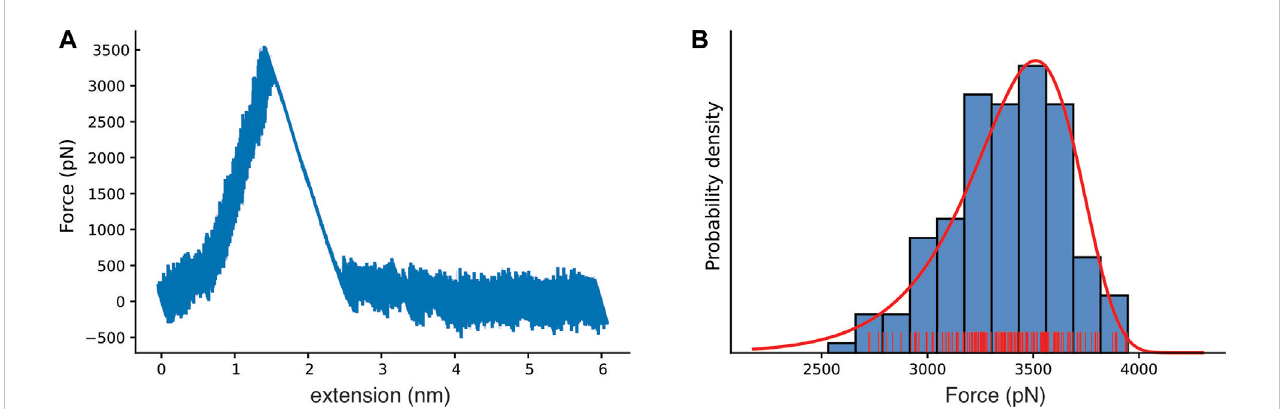
FIGURE 2 Bbp mechanostability under high mechanical load. (A) Force versus extension curve as an exemplary trace, with rupture peak force at 3,510 pN. (B) Histogram for the most probable rupture force (blue, rugged plot in red) with the Bell-Evans (BE) model for the fi rst rupture peak (red), based on the all-atom